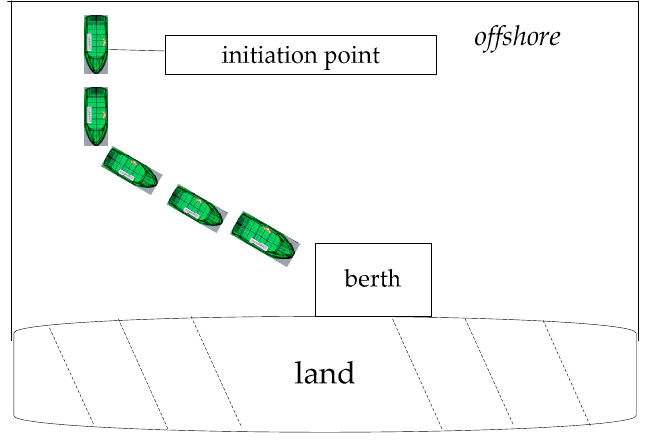
Figure 1. Ship berthing diagram.